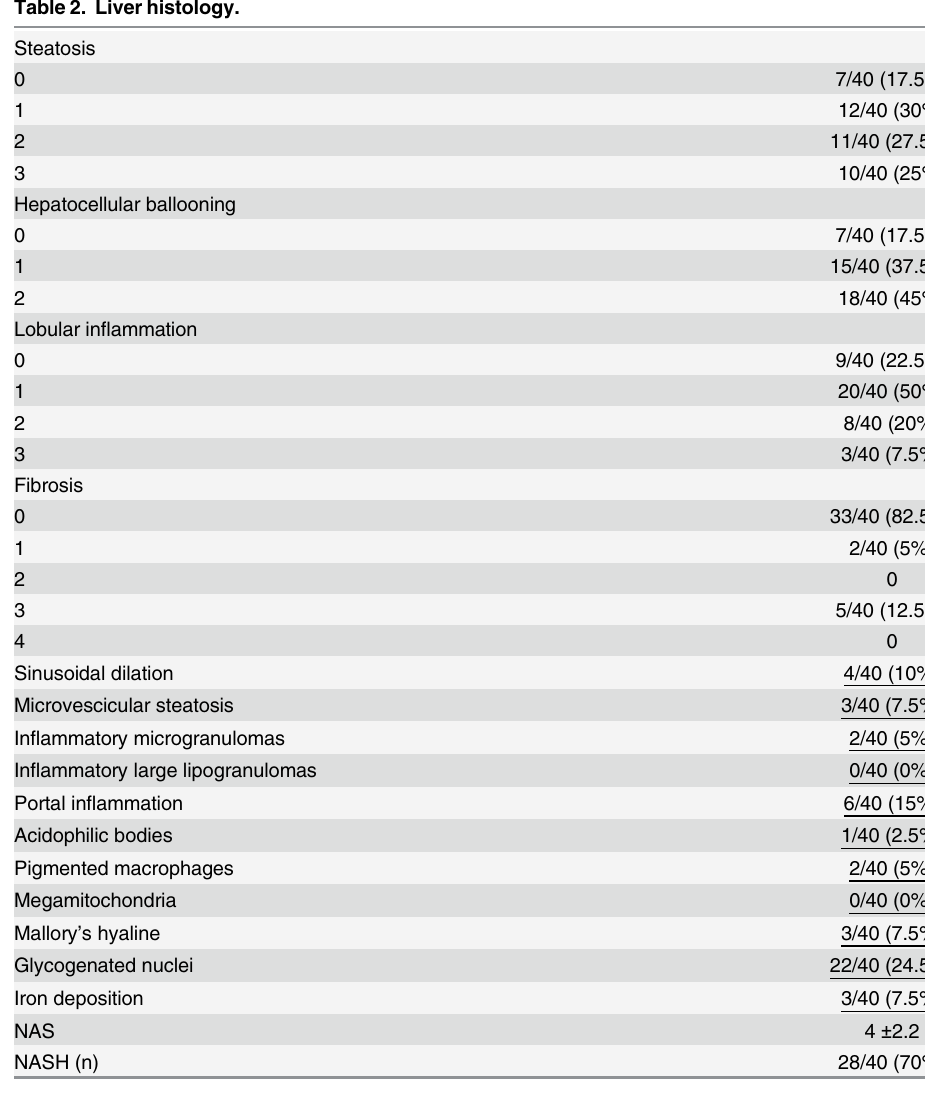
Non-alcoholic Fatty Liver Disease (NAFLD) Activity Score (NAS) was calculated as the sum of the subscores for steatosis, lobular in fl ammation and